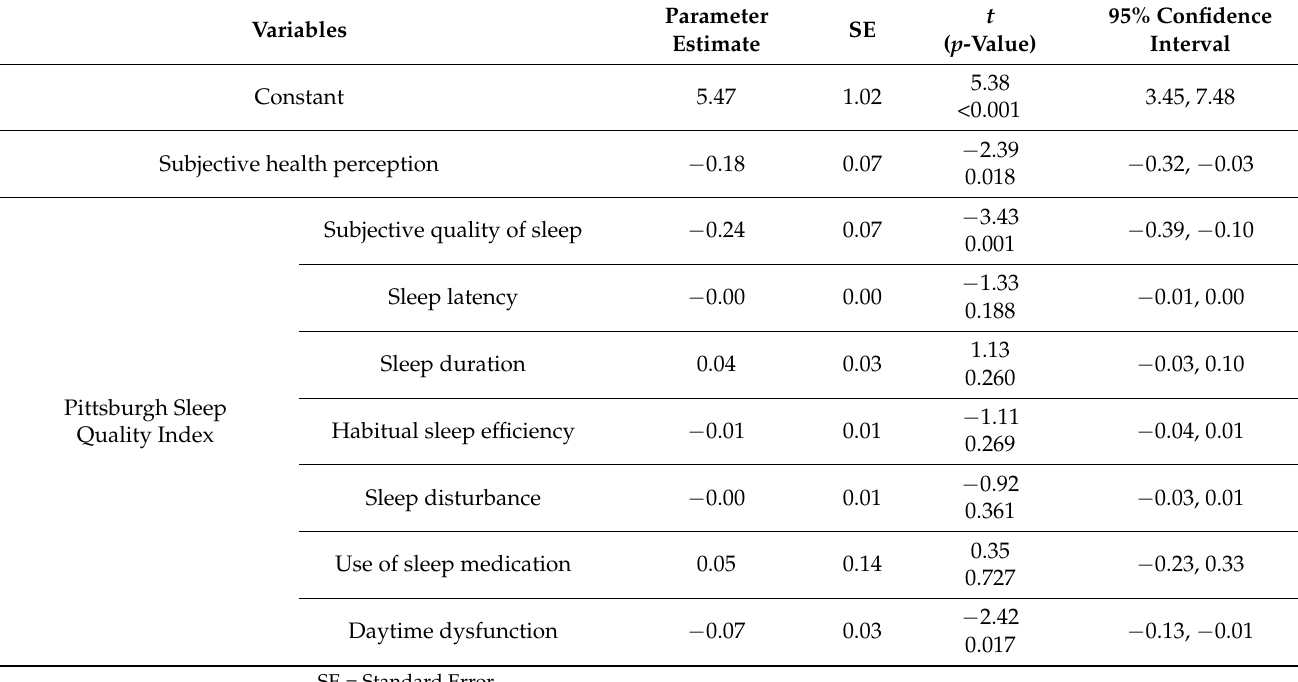
Table 4. Influencing factors on the participants’ quality of life changes ( N =